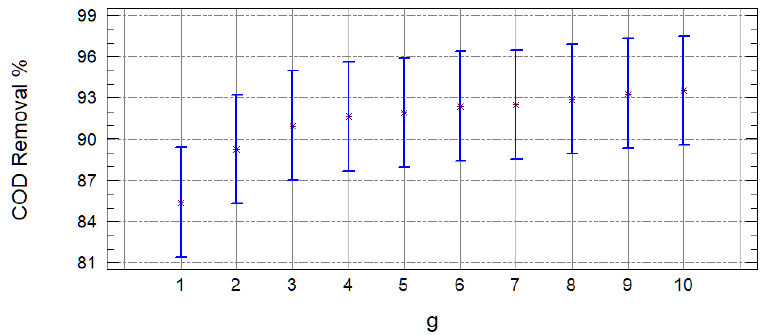
Figure 5. Mean charts of the COD removal efficiency in FE, according to the amount (g) of carbon used.